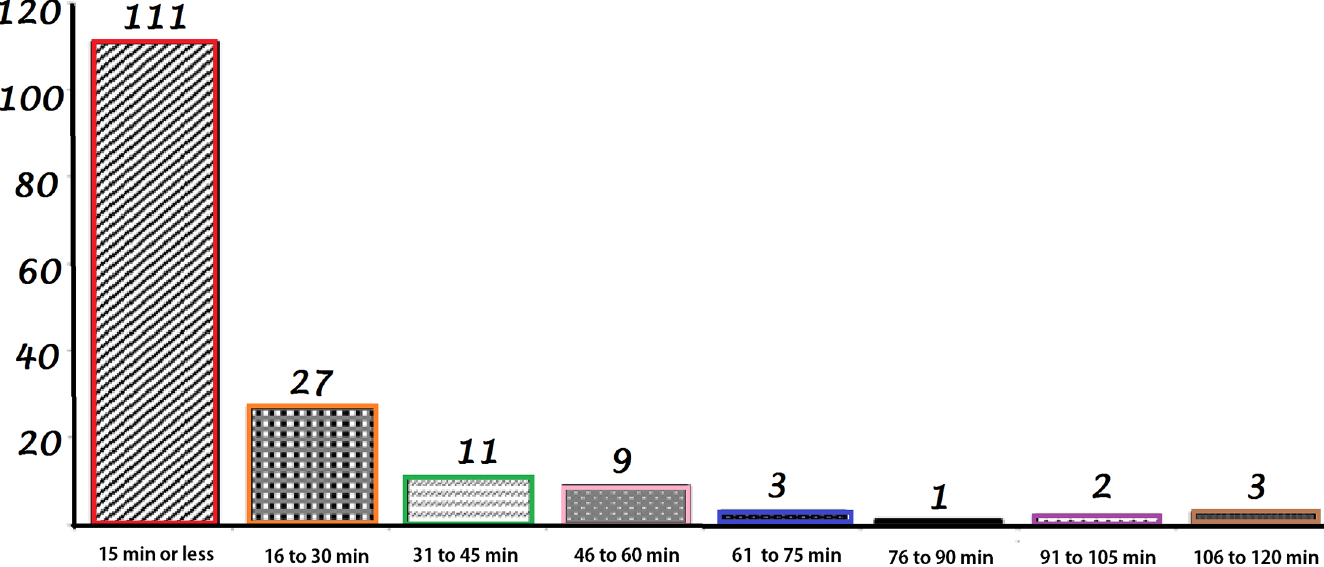
Fig 1. Distribution of VA hospitals as a function of the travel time to the nearest teaching hospital. As shown in this histogram, nearly all VA hospitals are within 60 minutes’ travel time.